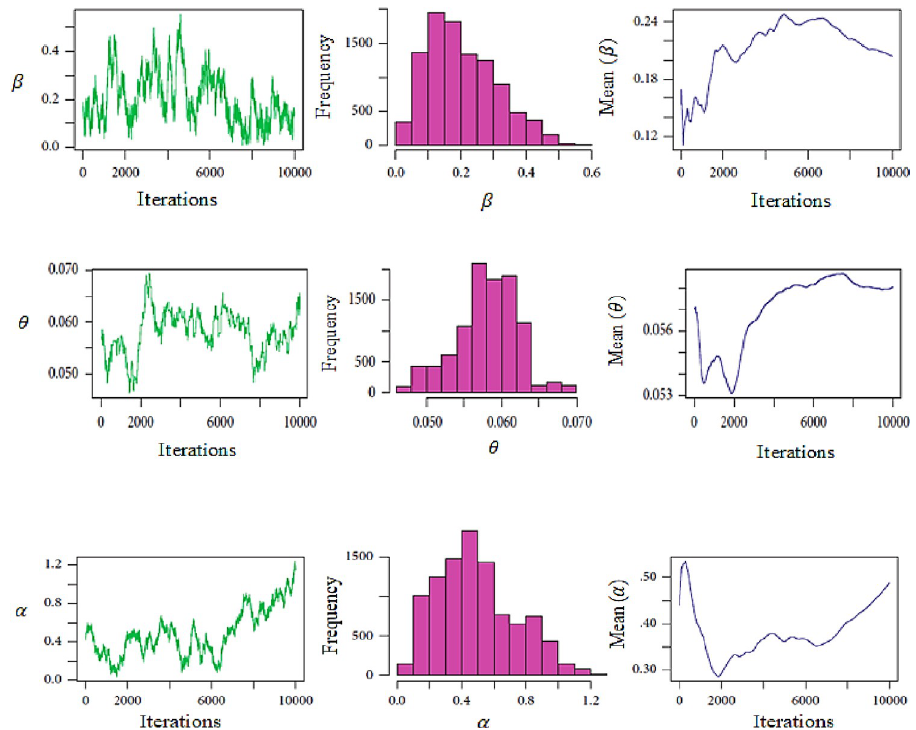
Fig 4. MCMC plots based on Type-II censored sample of MOP distribution for data set.